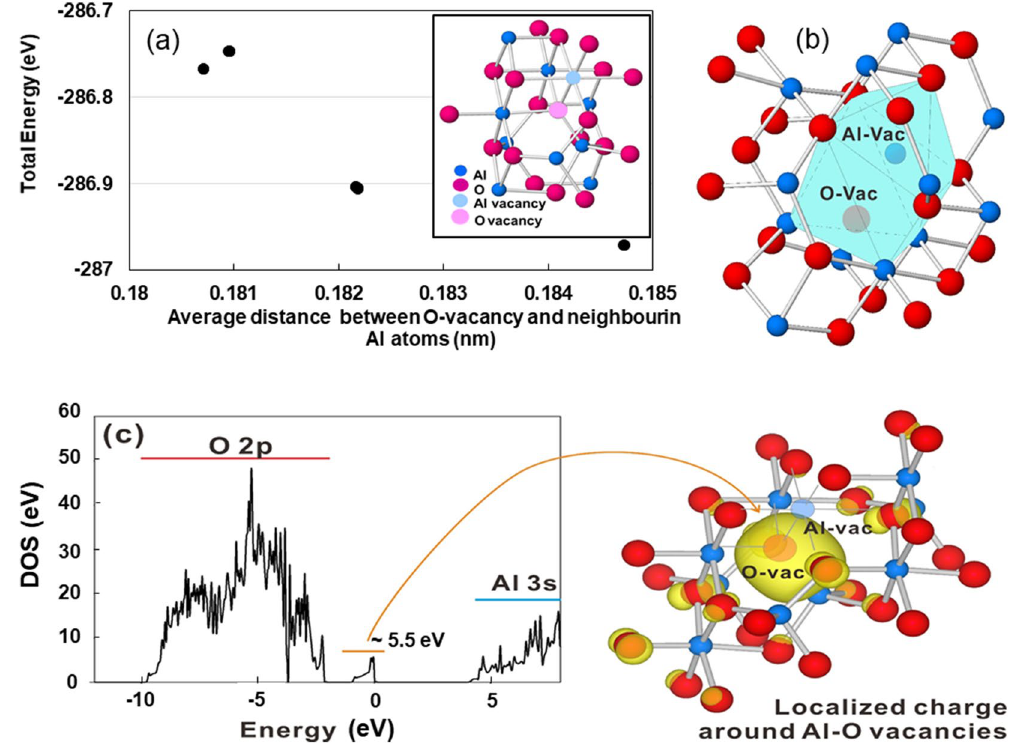
Figure 2. ( a ) Relation between energy and atomic distance between O vacancy and its neighbouring Al vacancies. Inset in ( a ): Optimised structure of AlO 6 cluster with oxygen and aluminium vacancies. ( b ) Vacant cage produced by deficit of an O atom and its neighbouring Al atom in AlO 6 cluster. ( c ) Density of state for O 2 p and Al 3 s in AlO 6 cluster. Isolated electronic state locally occurs in vicinity of two-atom